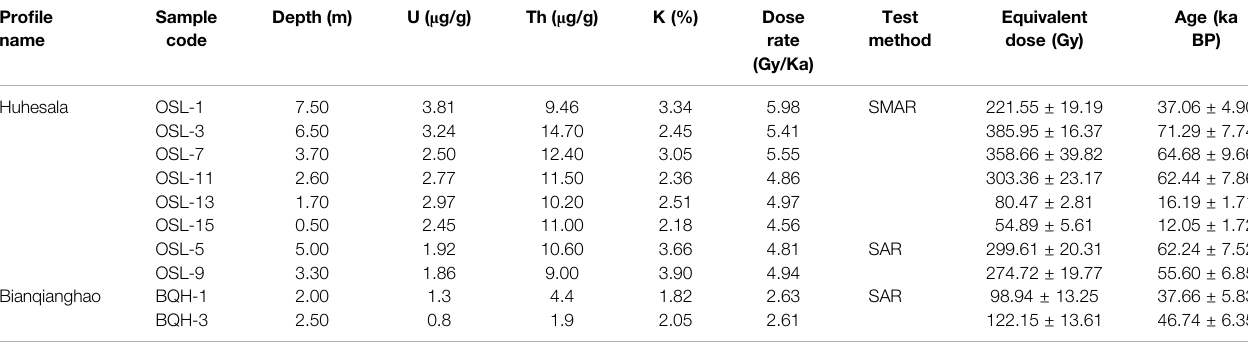
TABLE 2 | Results from the OSL dating of samples collected in Huhesala pro fi le and Bianqianghao pro fi le. Pro fi le